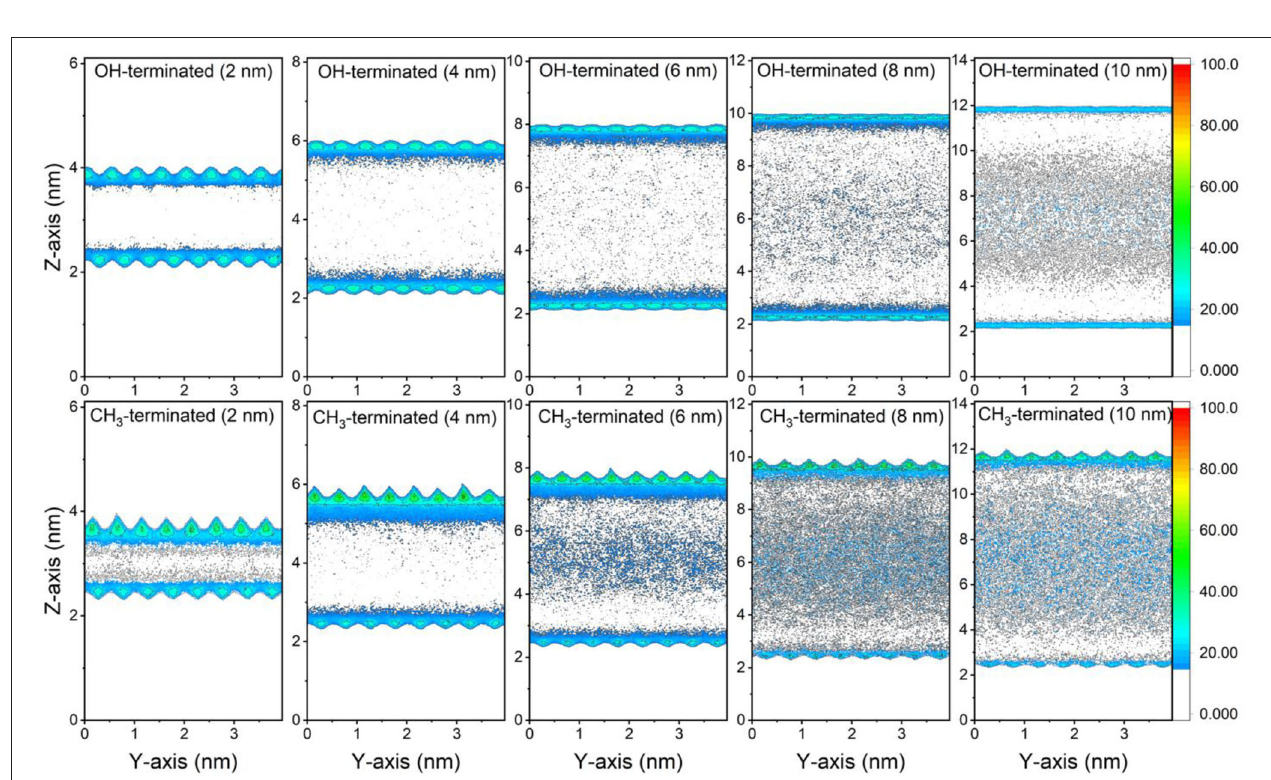
FIGURE 4 | 2D density maps of CH 4 confined in OH-terminated and CH 3 -terminated pores as a function of the pore diameter. The density maps are averaged over the last 10 ns of the simulation times.